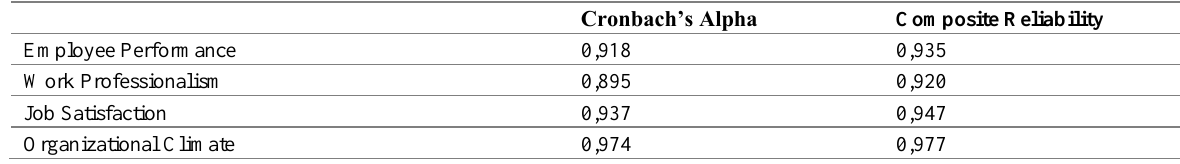
Table 4 : Reliability Analysis